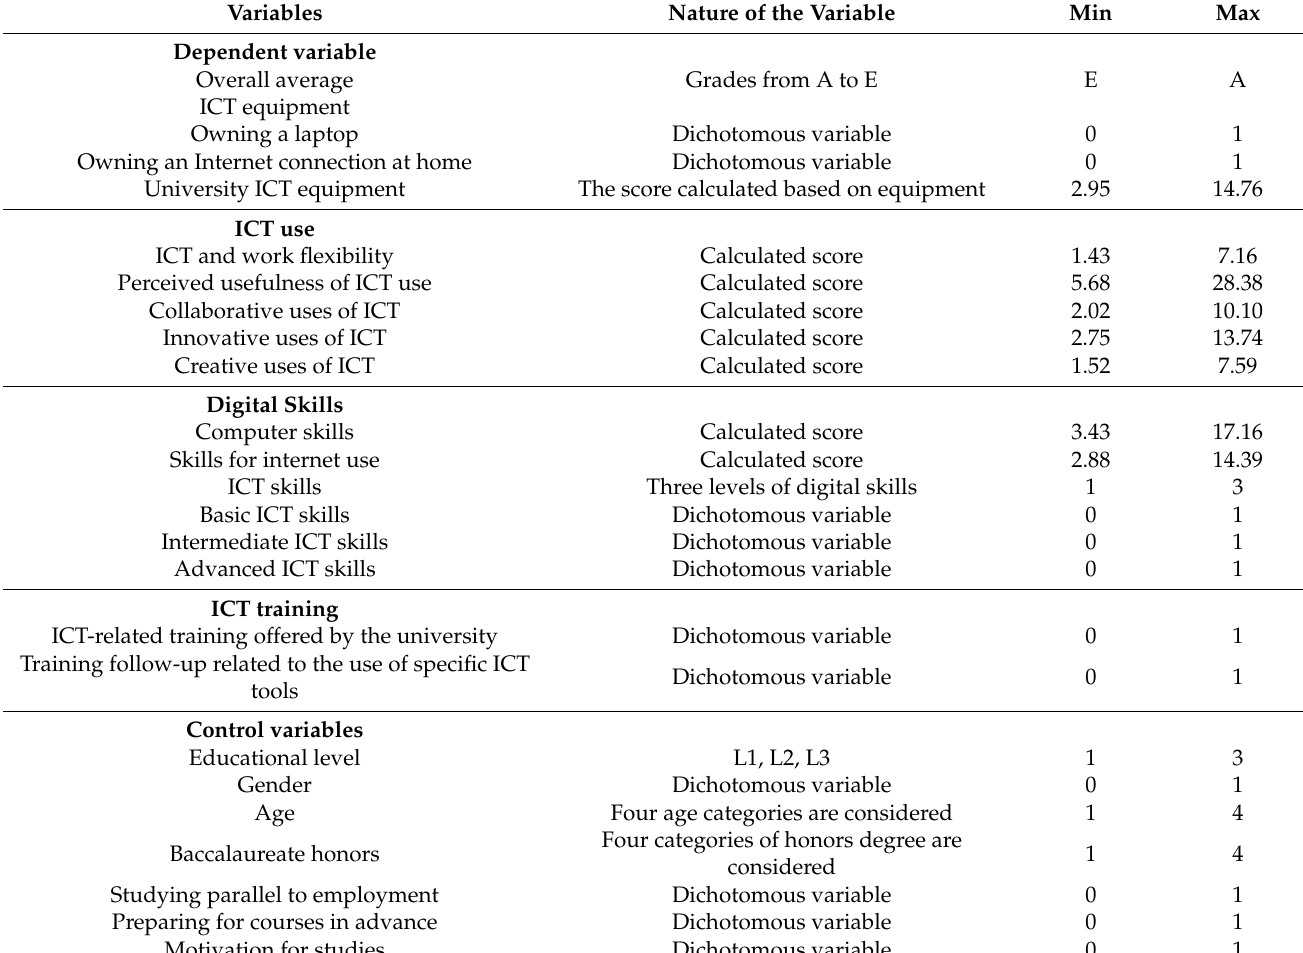
Table 2. List of